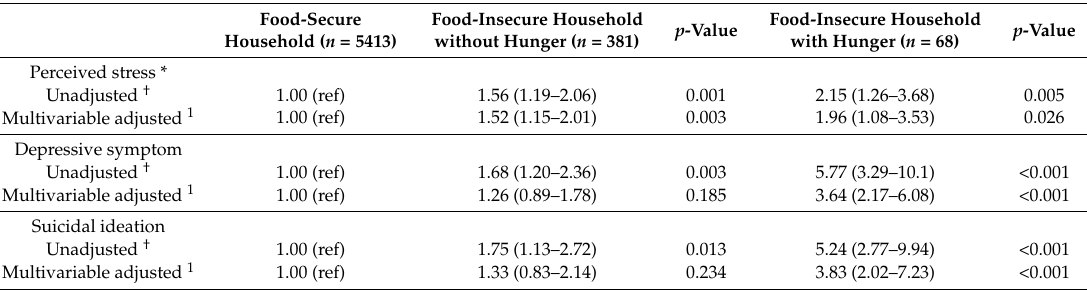
Table 3. Odds ratios and 95% confidence intervals for the mental health indicators per types of household food security.